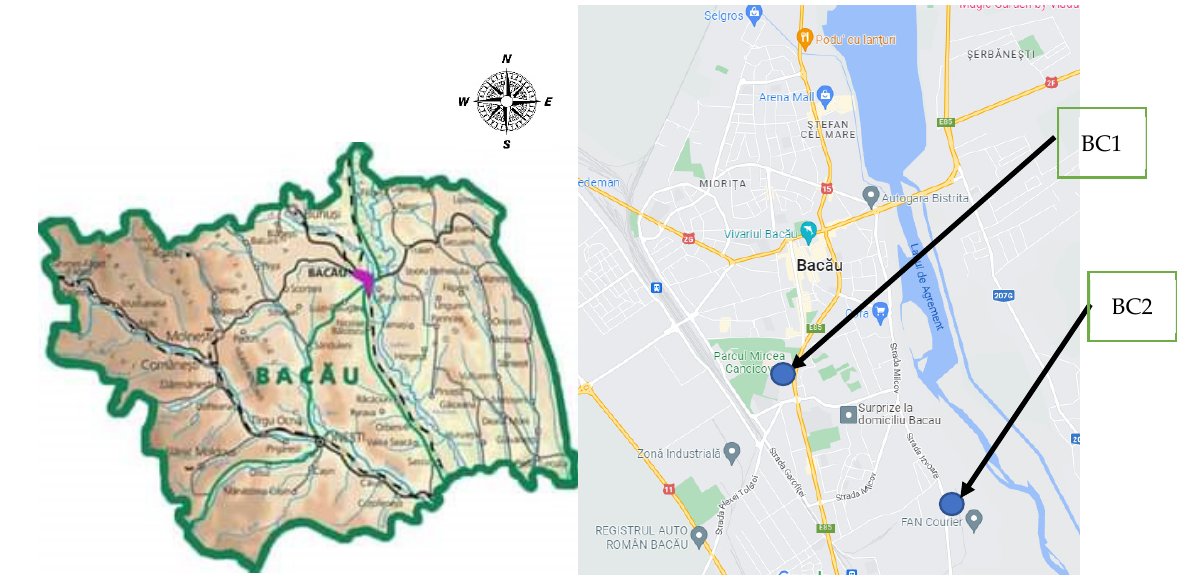
Figure 2. Location of air quality monitoring stations in Bacau County. Table 1. The description of the measurement points [12].